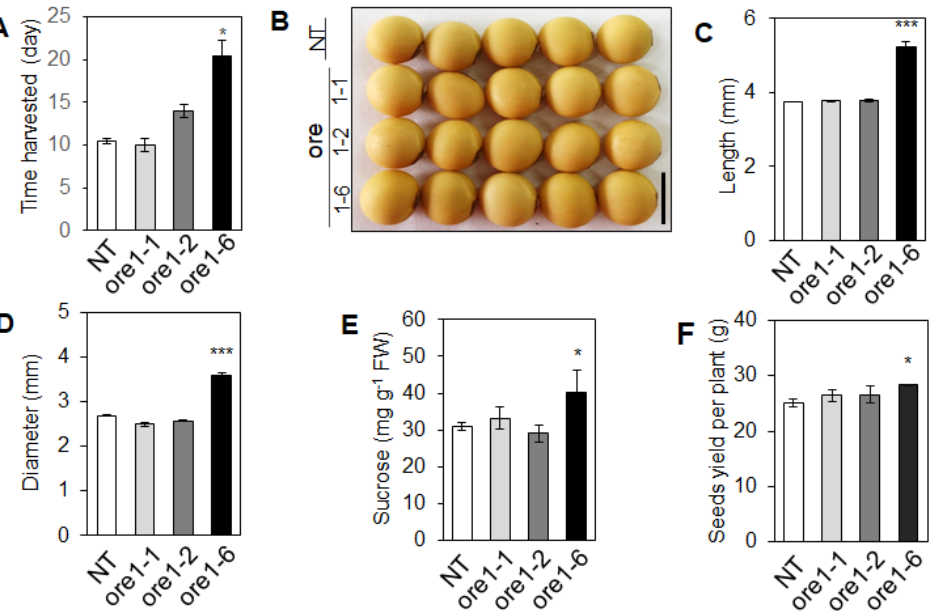
Figure 8. Seed yield from Atore1 -expressing soybean. ( A ) Comparison of the time harvested in wild-type (NT) and transgenic lines ( ore1 -1, ore1 -2, ore1 -6). Harvest time begins when the pods turn yellow. ( B ) Sizes of seed harvested from the genotype of the wild-type and transgenic lines. ( C ) Length and ( D ) diameter of harvested seeds at the R8 harvesting stage. ( E ) Sucrose content in seeds. ( F ) Seed yield per plant. Data are means ± SE of three independent replicates ( n = 3). Asterisks indicate significant differences from NT and transgenic lines according to Tukey’s t -test; * p < 0.05, *** p < 0.001.